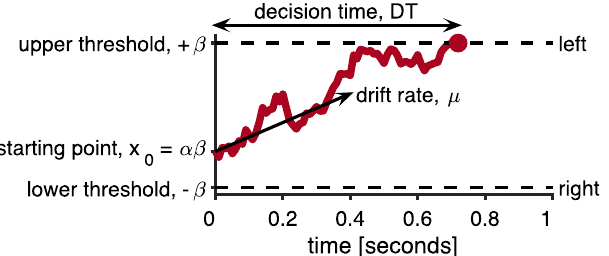
Figure 1. Schematic of the drift diffusion model showing the parameterization used in this